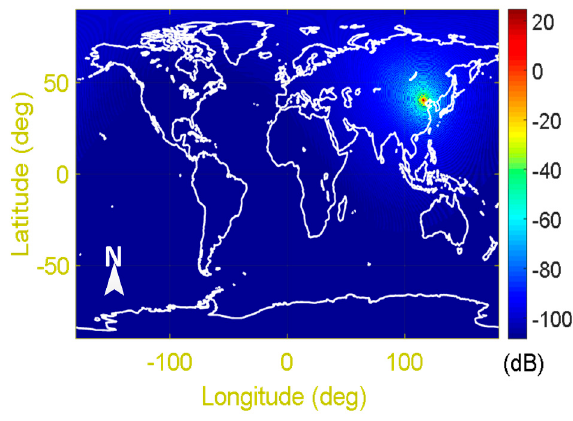
Figure A9. GEO SAR SINR based on Sentinel-1 data.